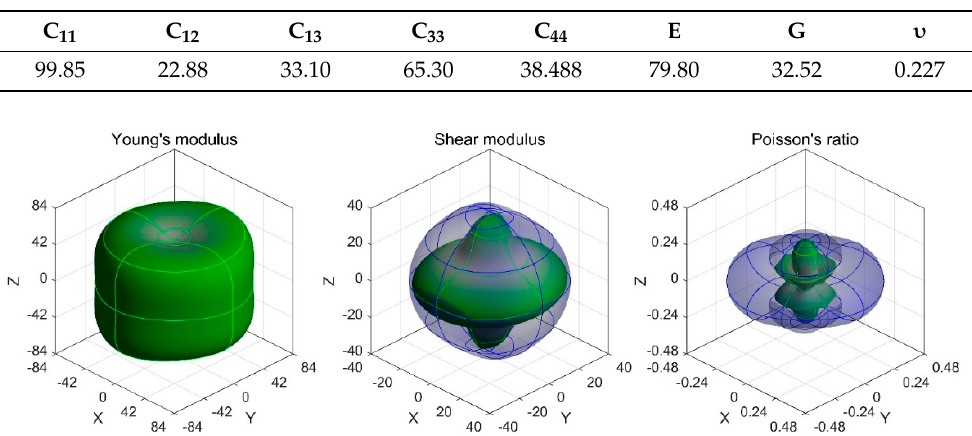
Table 1. The calculated various elastic constants (C ij ), Young’s modulus E, shear modulus G and Poisson’s ratio ν for the ternary phosphide BaLiP. All units are in GPa, except no unit for the Poisson’s ratio.